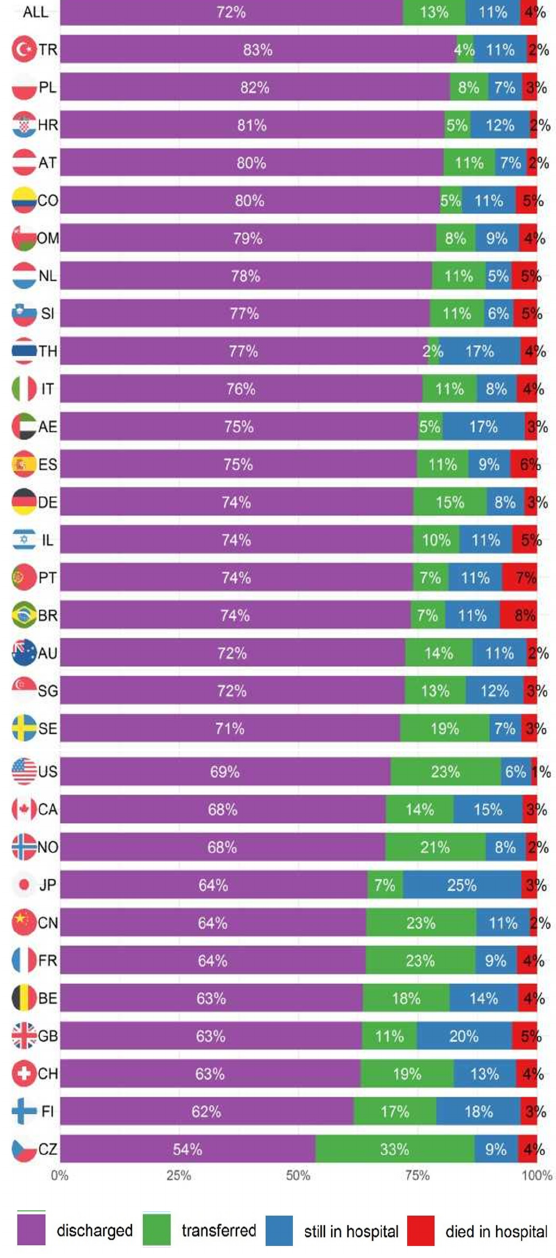
Figure 2. Proportion of outcomes 30 days after nutritionDay by country.